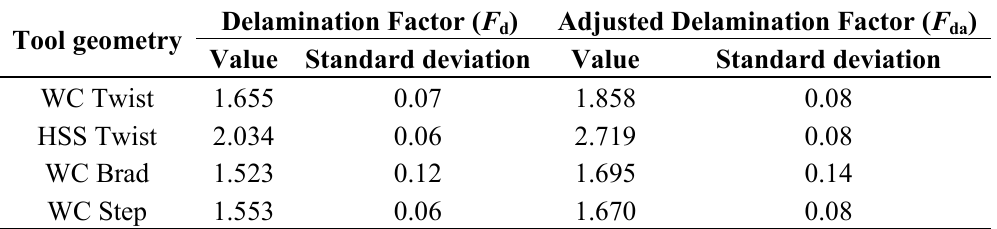
Table 2. Results of the delamination criteria for tool geometry and tool